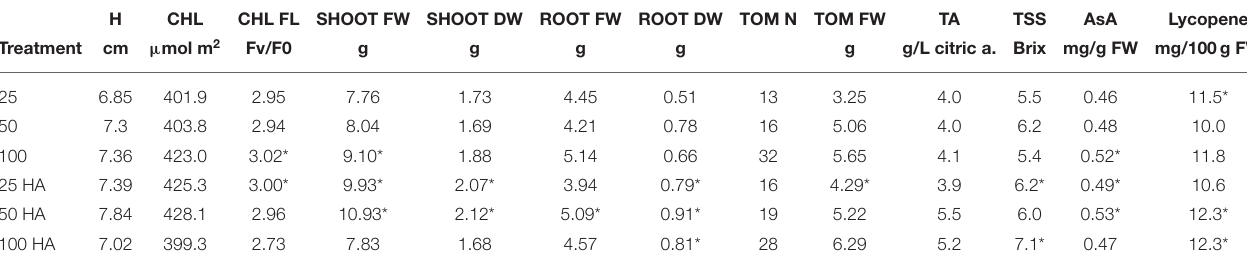
TABLE 5 | Plant morphological mean data, tomatoes yield, and quality parameters. H CHL